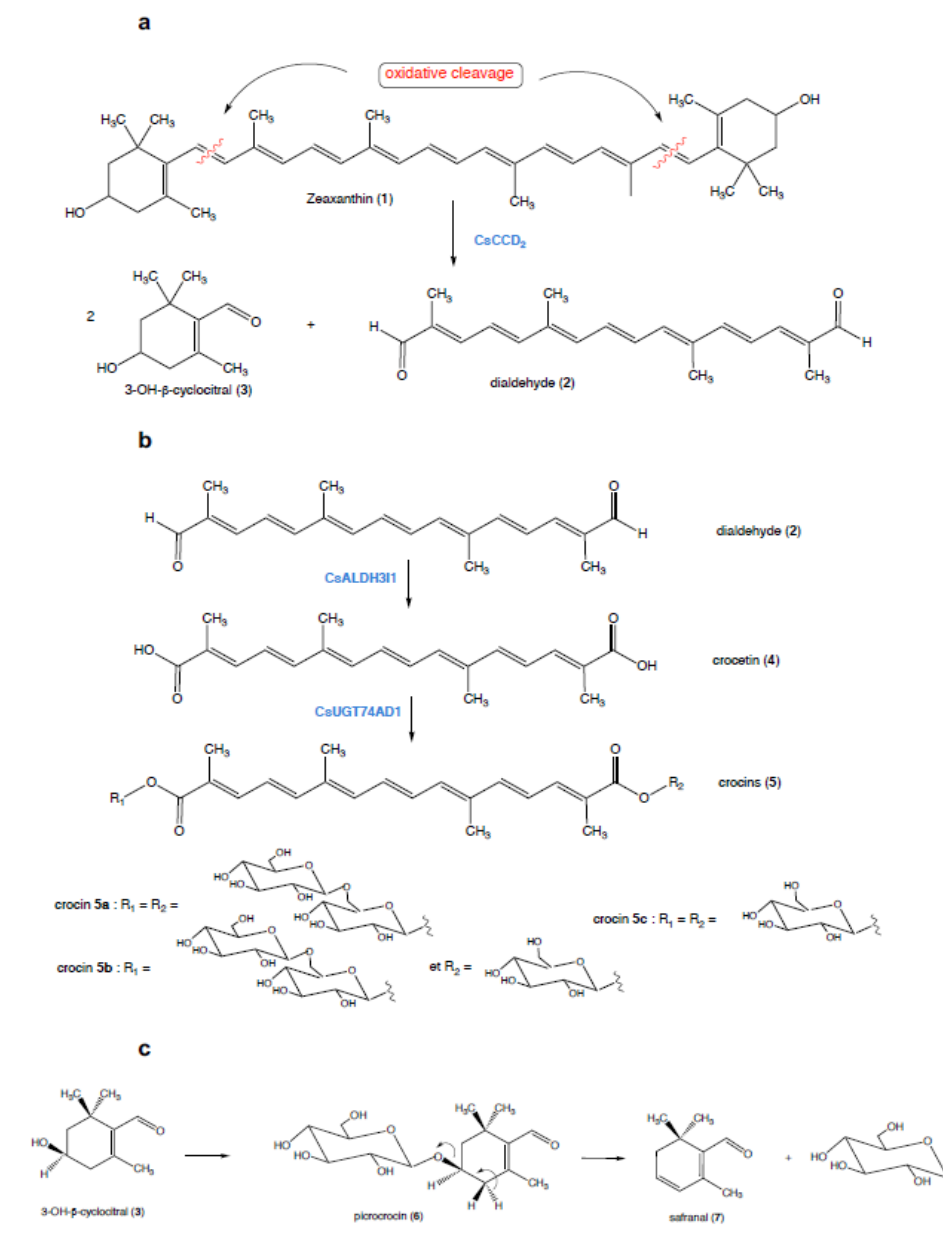
Scheme 1. Biosynthesis of the main compounds (crocetin, crocins, picrocrocin, safranal) of saffron from zeaxanthin; ( a ) oxidative cleavage; ( b ) enzymatic modification in saffron; ( c ) different steps of safranal synthesis (Dominique Vervandier-Fasseur, Université de Bourgogne). Oxidative transformation of ( 2) in diacid, named crocetin ( 4 ), followed with a di-es- terification furnish crocins ( 5 ) (Scheme 1b). As shown in Scheme 1b, different molecules of crocin exist depending on the structure of the R1 and R2 radicals. The alcohol function of the apocarotenoid fragments ( 3) is transformed in glycosyl ether to give picrocrocin ( 6 ).